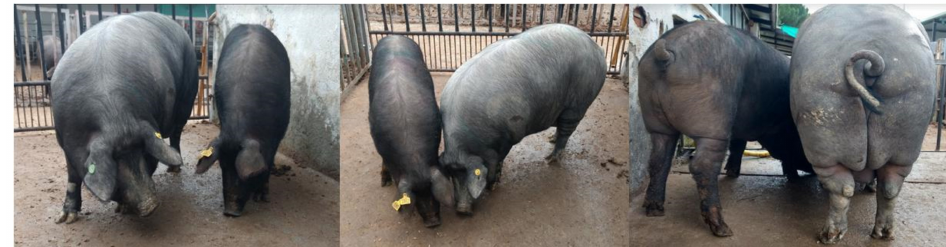
Figure 3. Corpulence and adiposity in pigs fed with the maintenance diet (MD) or fattening diet